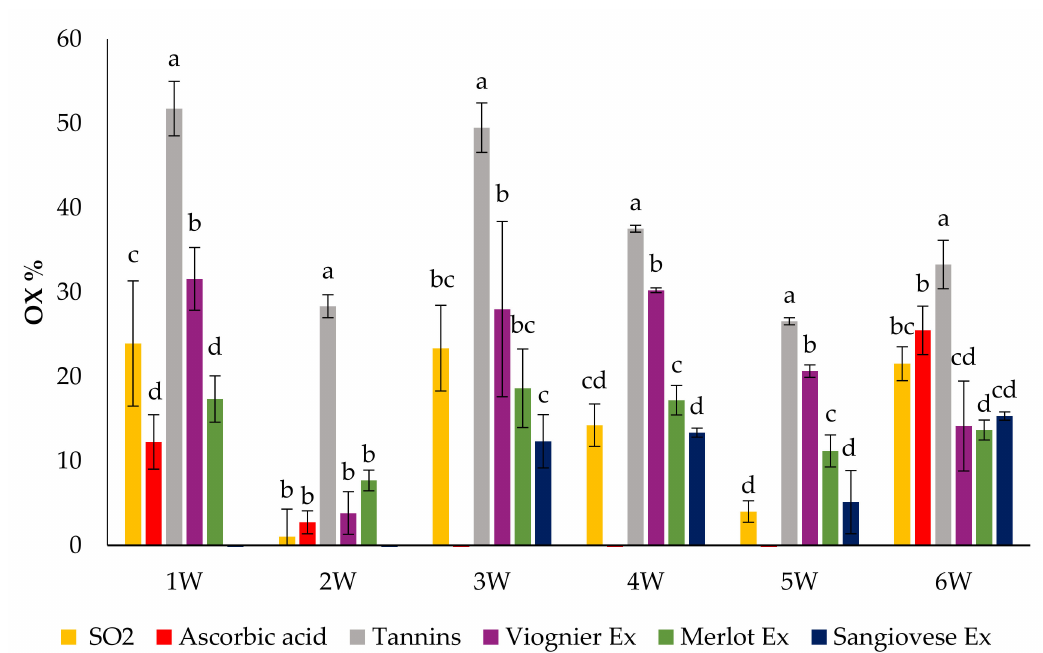
Figure 6. Percentage of colour oxidation of 6 white wines in the POM test performed after the addition of the UG extracts and commercial products. Values are the mean ± SD ( n = 3). Bars represent standard error. Different letters indicate significantly different values among the samples ( p < 0.001).